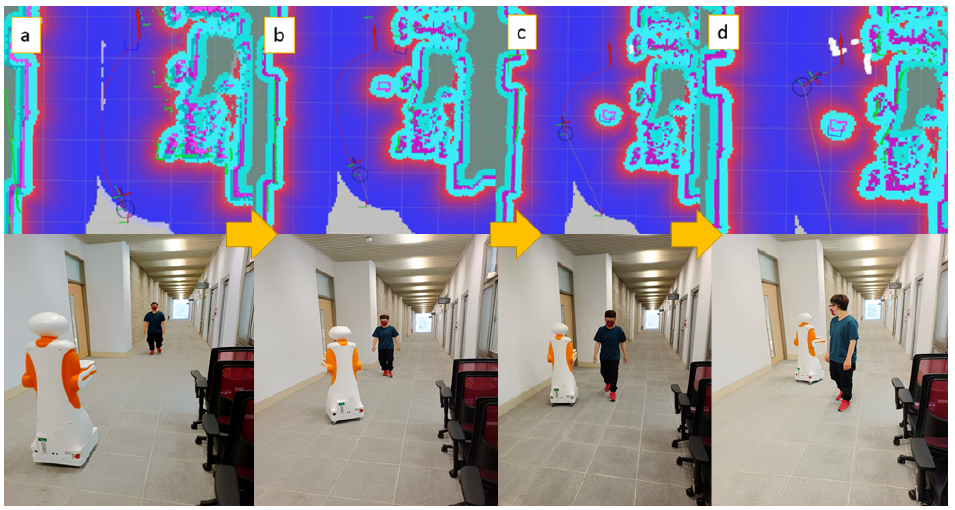
Figure 19. The subfigures ( a – d ) illustrate the obstacle avoidance process of the actual robot with the velocity obstacle layer.